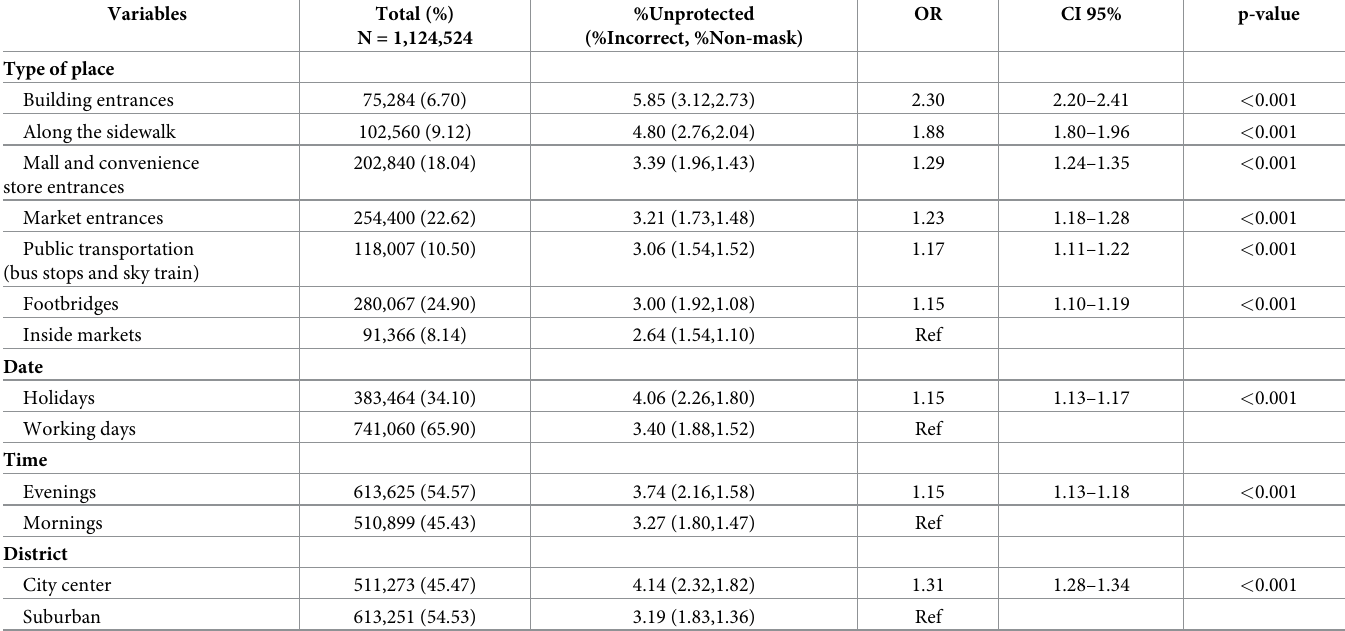
Table 3. Univariate logistic regression analysis of the unprotected group divided into type of public place, date, time, and districts.